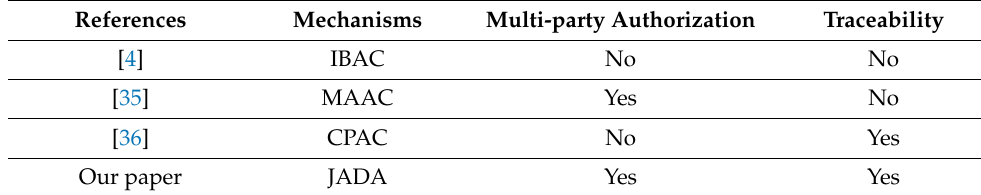
Table 3. Comparison of relevant access control